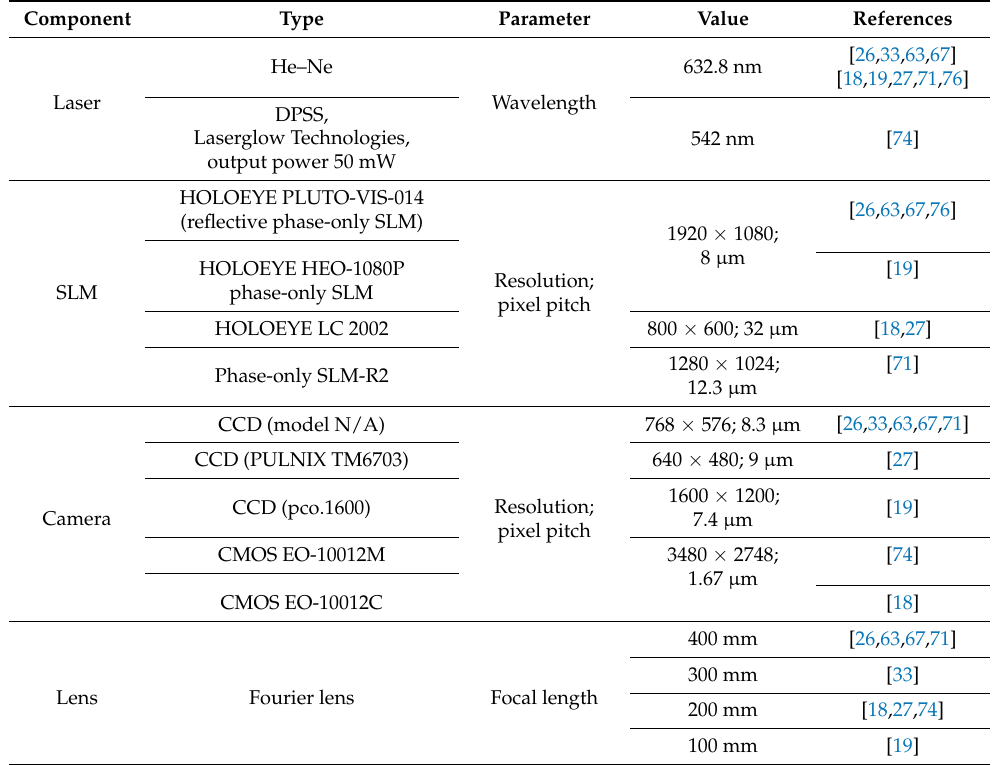
Table 1. Comparison between the most important parameters of the JTC setup in various proposed ar-